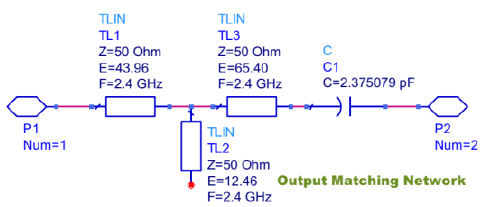
Fig. 11. Preliminary output matching